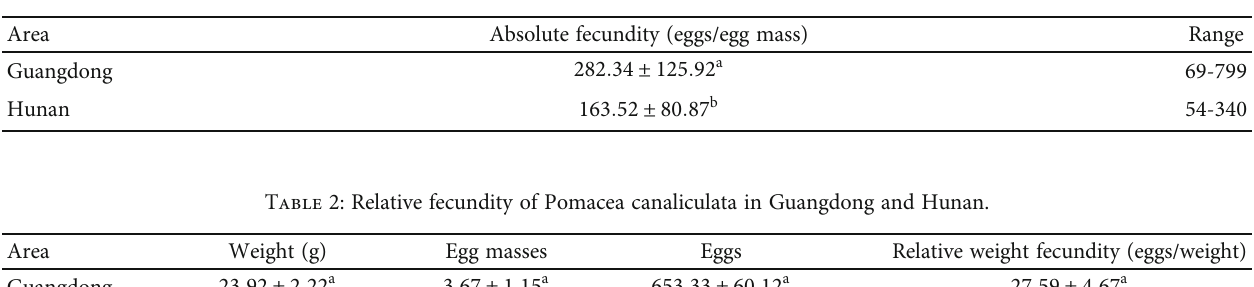
Table 1: Absolute fecundity of Pomacea canaliculata in Guangdong and